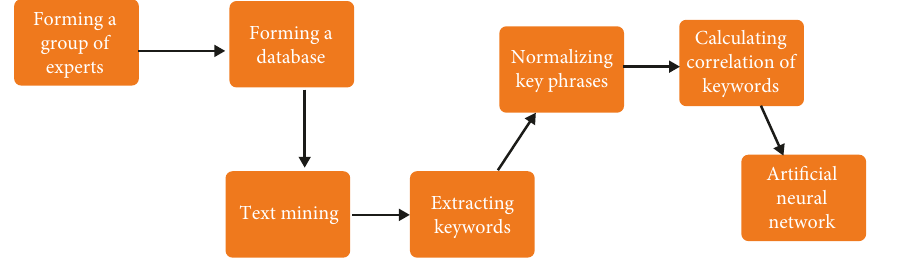
Figure 1: The framework of the proposed methodology. Table 1: Frequency of keywords in each